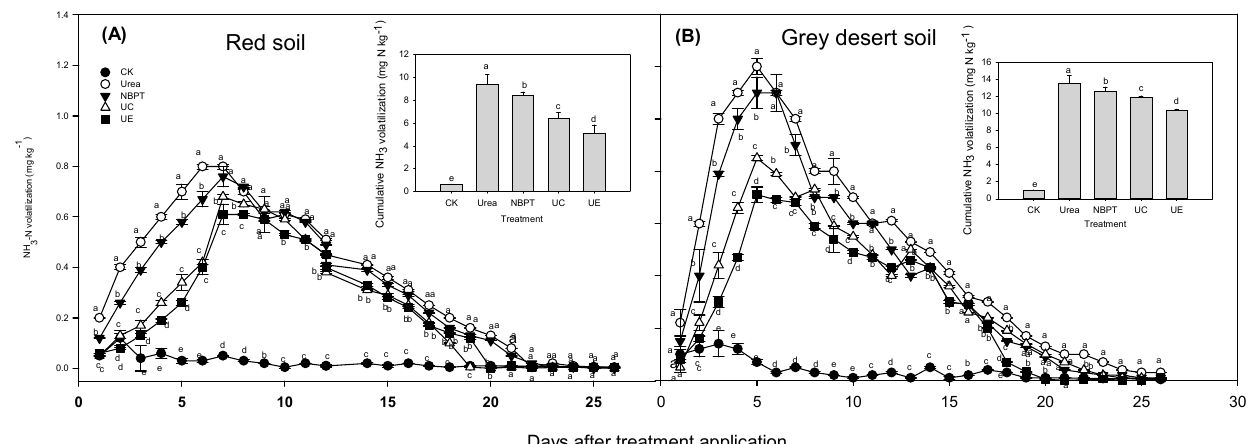
Figure 1. The dynamics of NH 3 fluxes and cumulative NH 3 volatilizations in red ( A ) and grey desert ( B ) soils receiving five treatments. Data are presented as mean values with standard errors (n = 3). CK, no N fertilizer control; Urea, urea application alone; NBPT, urea + NBPT; UC, urea + 2-Cyclopenten-1-one; UE, urea + Eugenol. (Different letters indicate significant differences ( p < 0.05) among treatments at the same sampling day.).